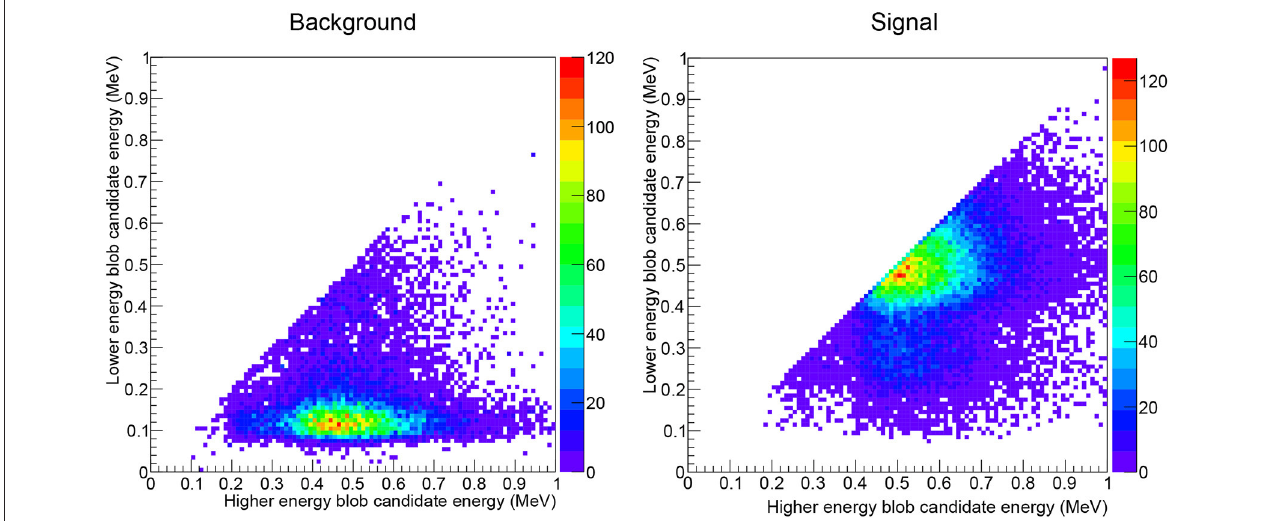
FIGURE 5 | The left panel shows the energy of the blob of lower energy vs. the energy of the blob of higher energy for a background electron propagating in a HPXe TPC—perfect track reconstruction. The right plot shows the same distribution referred to two electrons produced in a ββ 0 ν propagating under the same conditions. In the first case the energy of the lower energy blob is much smaller than the energy of the higher energy blob, in the second case both are roughly the